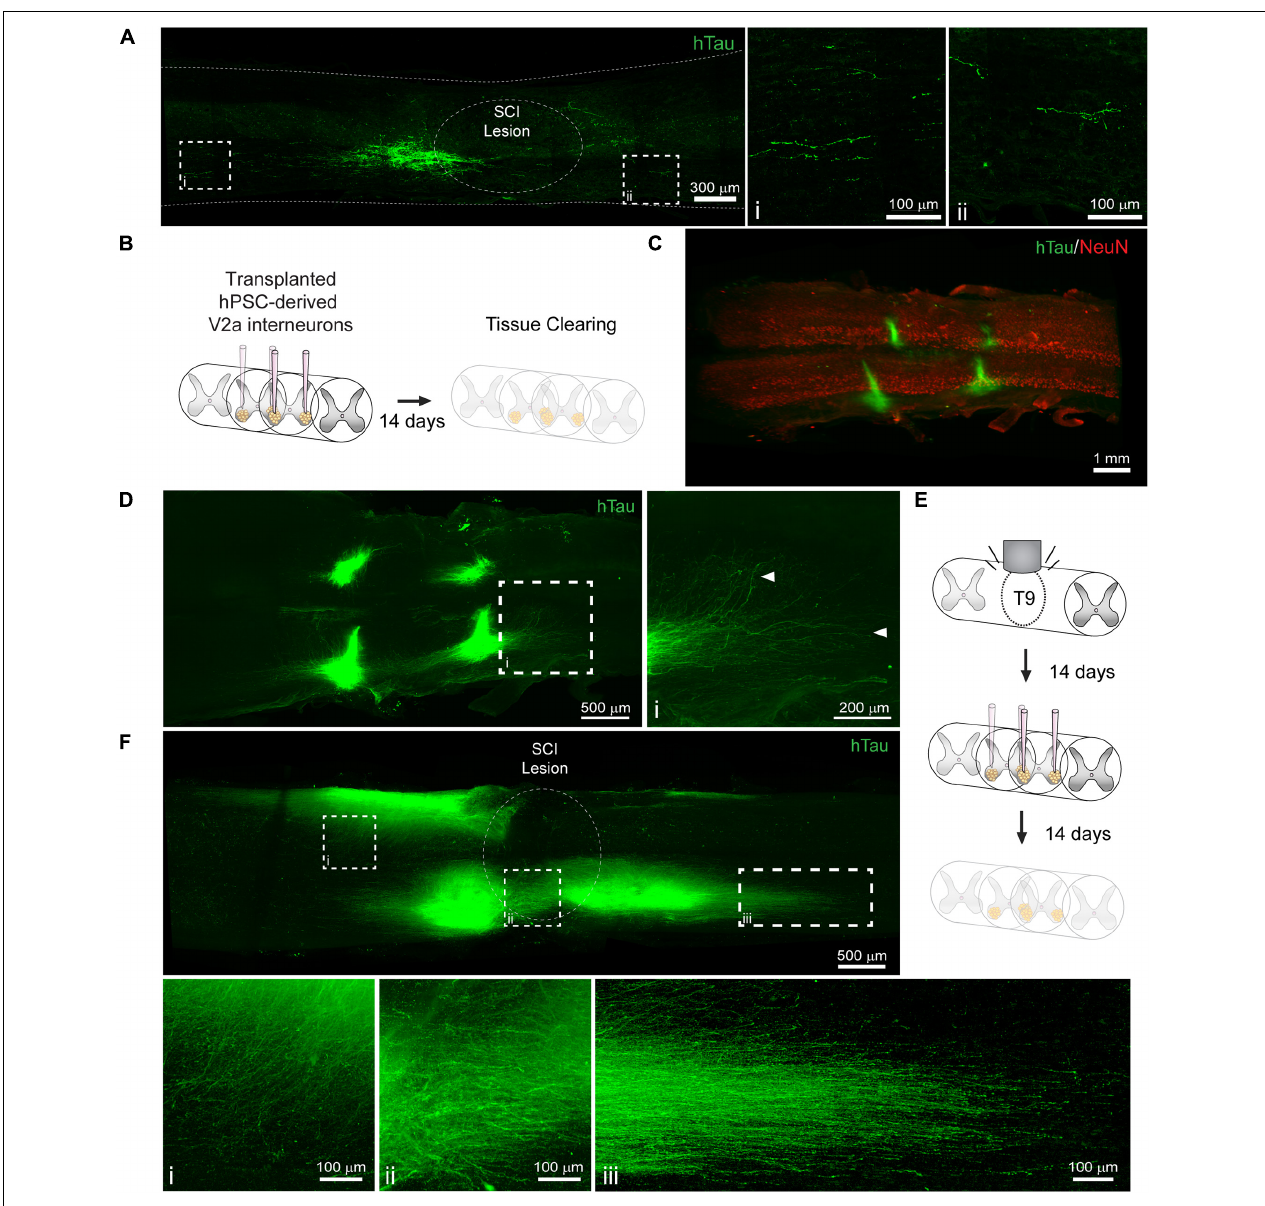
FIGURE 5 | Labeling and 3D imaging of transplanted hiPSC-derived V2a interneurons in the cleared intact and injured spinal cord of NSG mice. (A) hTau IF labeling in a sagittal section of the injured spinal cord at 14 days following transplantation. (i-ii) hTau + axons can only be visualized for a limited distance. (B) Schematic of hiPSC-derived V2a interneuron transplantation in the intact spinal cord and PACT clearing 14 days later. (C) 3D projection of hTau and NeuN IF labeling in the cleared intact spinal cord showing transplanted hiPSC-derived V2a interneurons. (D) Maximum intensity projection showing hTau + axon extension in the host spinal cord. (i) In cleared spinal cords, hTau + axons can be visualized for long distances from the transplant site. (E) Schematic of SCI, hiPSC-derived V2a interneuron transplantation, and PACT clearing. (F) Maximum intensity projection of hTau IF labeling of hiPSC-derived V2a interneurons at 14 days following transplantation in the injured spinal cord. Axon extension is observed into the grey matter (i) , around the SCI lesion site (ii) , and distally along the white matter (iii) . hiPSC, human induced pluripotent stem cell; hTau, human Tau; SCI, spinal cord